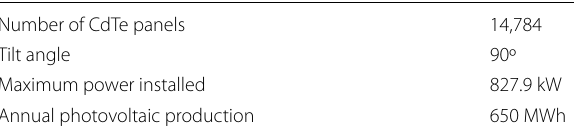
Table 16 Data for cadmium telluride photovoltaic